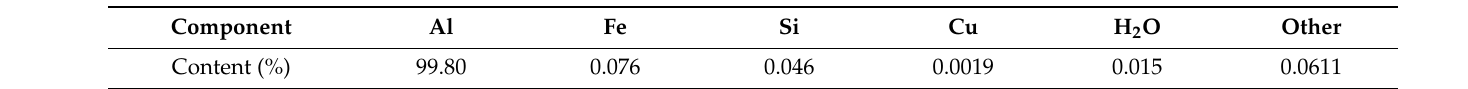
Table 4. Main composition of aluminum powder.